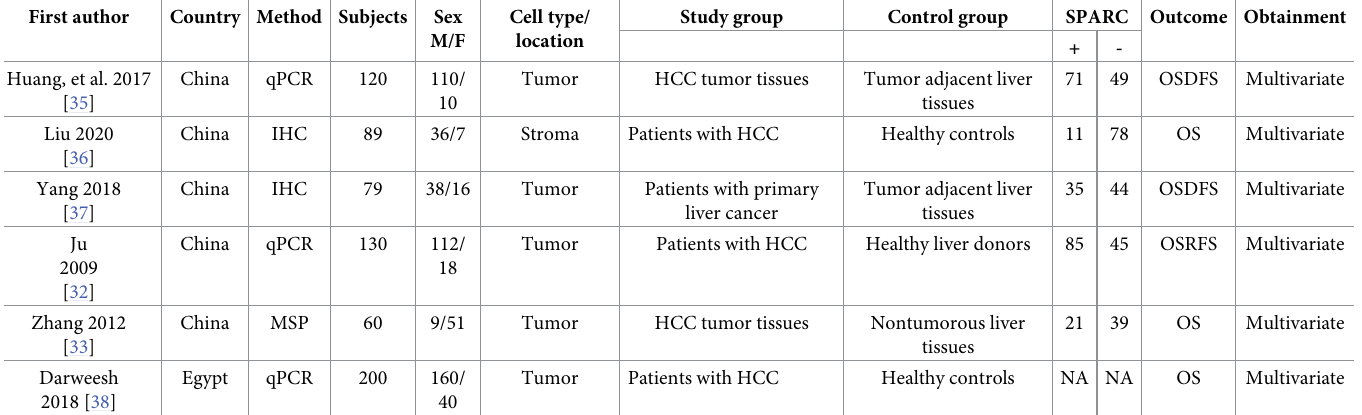
Table 1. Background characteristics of the study population.